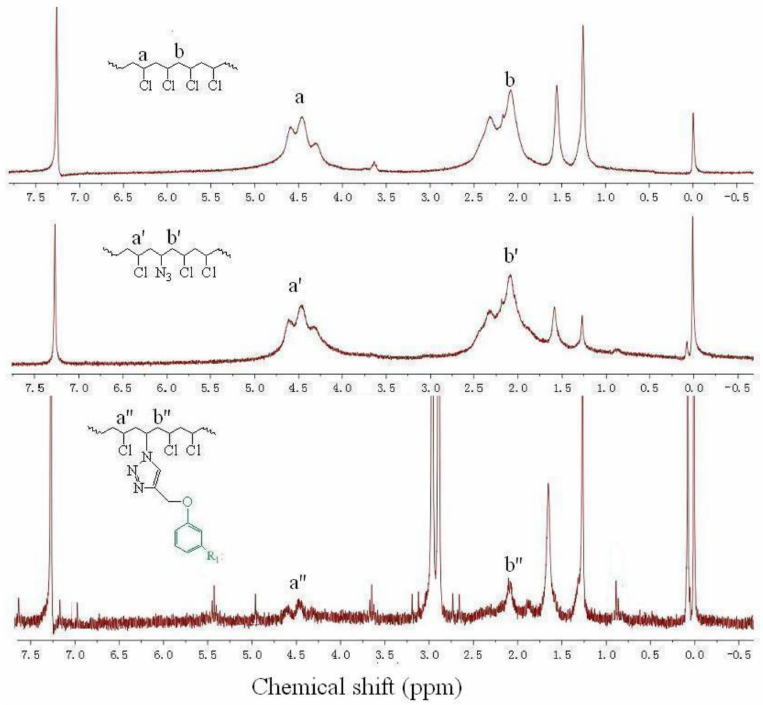
Figure 3. 1 H NMR of PVC and internally plasticized PVC materials.